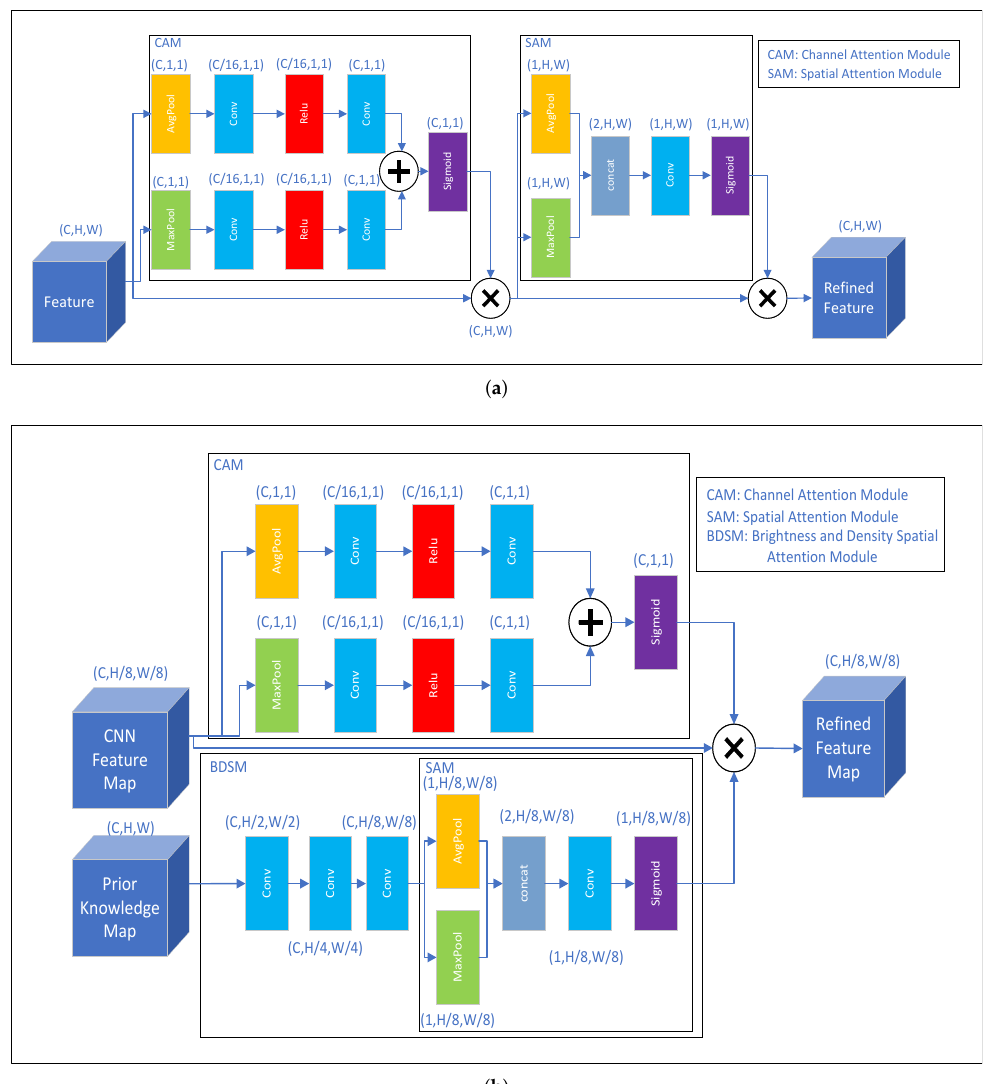
Figure 6. Comparison of CBAM and BDAM. ( a ) CBAM. ( b ) BDAM.